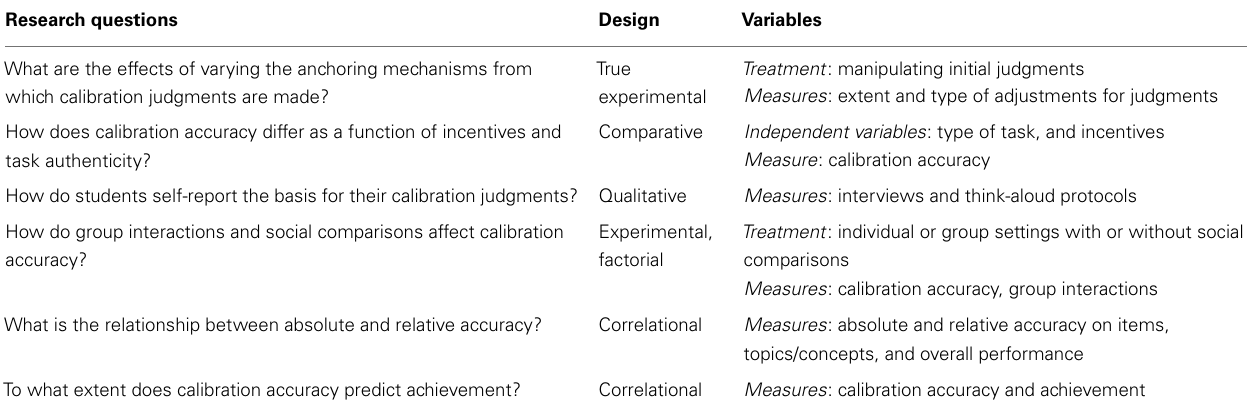
Table 1 | Proposed questions, design, and exemplar studies in calibration